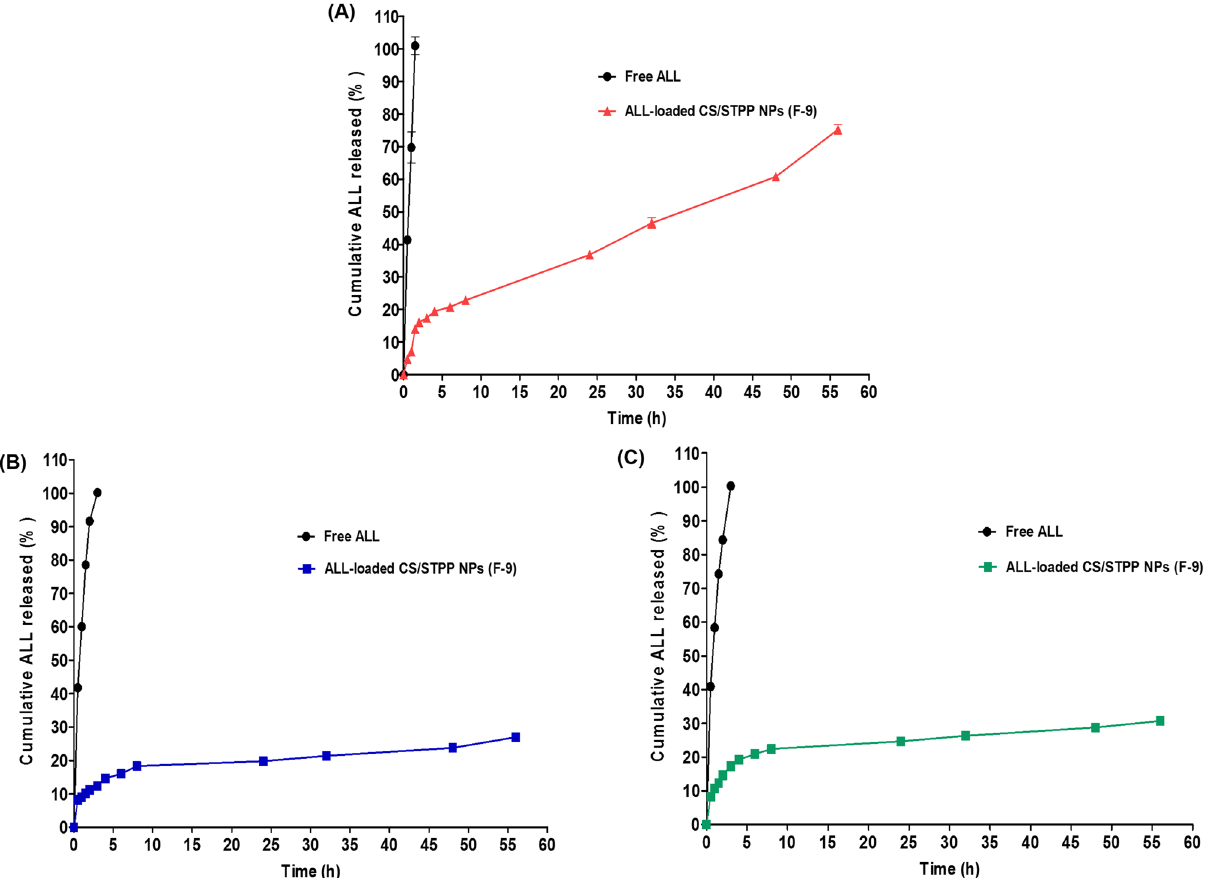
Figure 7. The in vitro release pattern of ALL from ALL-loaded CS/STPP NPs (F-9) in comparison with its diffusion from aqueous solution at three different pH values ( A ) pH 1.2, ( B ) pH 6.8 and ( C ) pH 7.4. Each point represents the mean ± SD (n = 3) and the graph was plotted using GraphPad Prism 5.00 (http://www.graph pad. com).